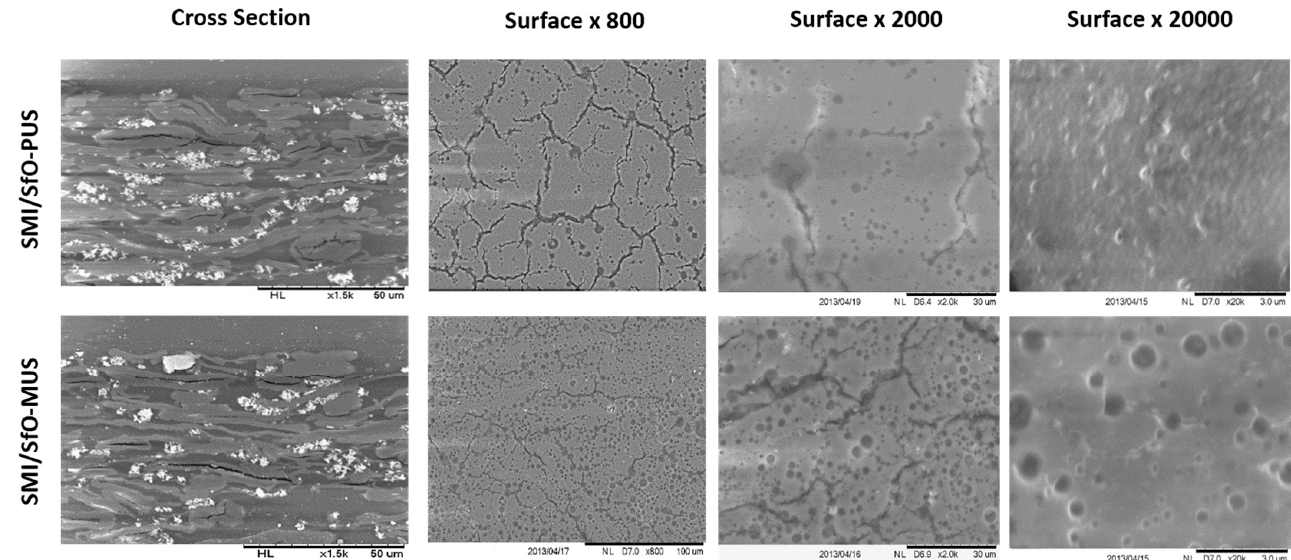
Figure 2. Scanning electron microscopy (SEM) images of original SMI/SfO-PUS and SMI/SfO-MUS coatings on paper substrates, including cross section (left column) and surface view at different magnifications.